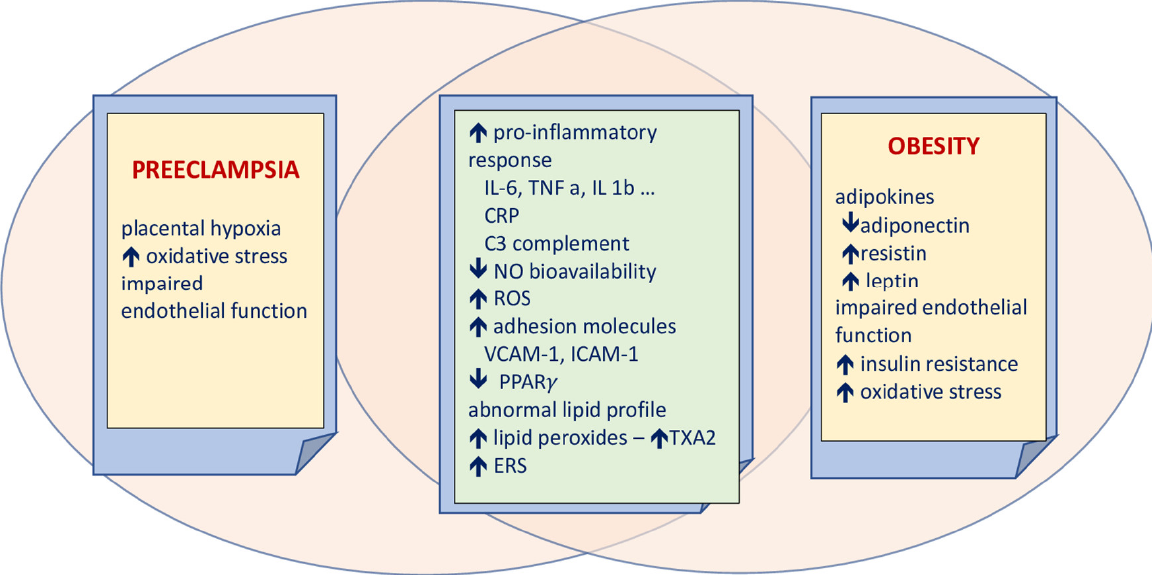
Figure 1. Main features of preeclampsia and obesity. IL-6—interleukin 6, TNF —tumor necrosis factor , IL-1 —interleukin 1 , CRP—C-reactive protein, NO—nitric oxide, ROS—reactive oxygen species, VCAM-1—Vascular Cell Adhesion Molecule 1, ICAM-1—Intercellular Adhesion Molecule 1, PPAR —Peroxisome Proliferator-Activated Receptor-γ, TXA2—thromboxane A2, ERS—endoplasmic reticulum stress.